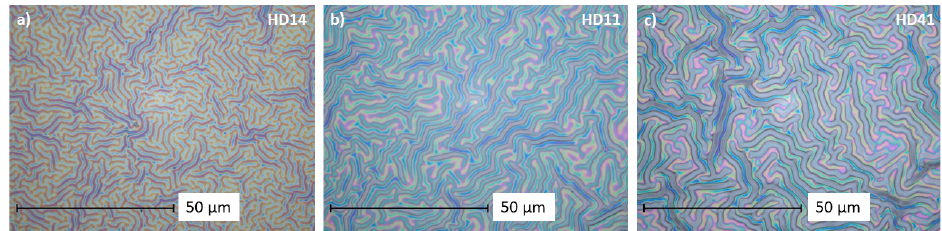
Figure 2. Microscopic images of the hydrogel films ( a ): d-HD14, ( b ): d-HD11, and ( c ): d-HD41 at 1500× magnification.